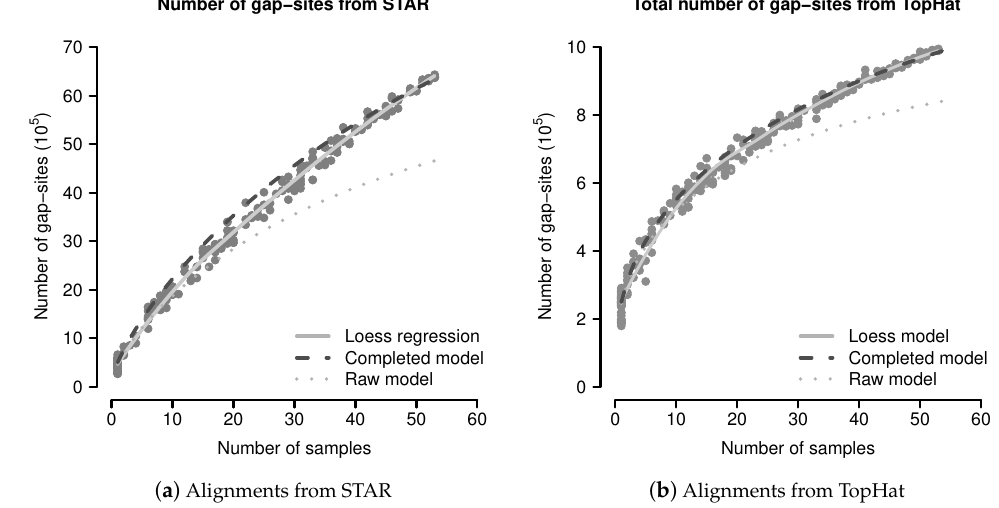
Figure 3. Observed and predicted numbers of gap-sites: ( a ) Alignments from STAR; ( b ) Alignments from TopHat. Observed number of gap-sites ( y -axis) from 200 randomly drawn sub-batches with varying numbers of samples ( x -axis) are shown as solid circles (dark gray). Results from a Loess regression are shown as solid line (light gray). The predictions from the (uncorrected) raw model indicate a too small terminal slope (dotted line). The predictions from the completed model indicate improved consistency with the observed